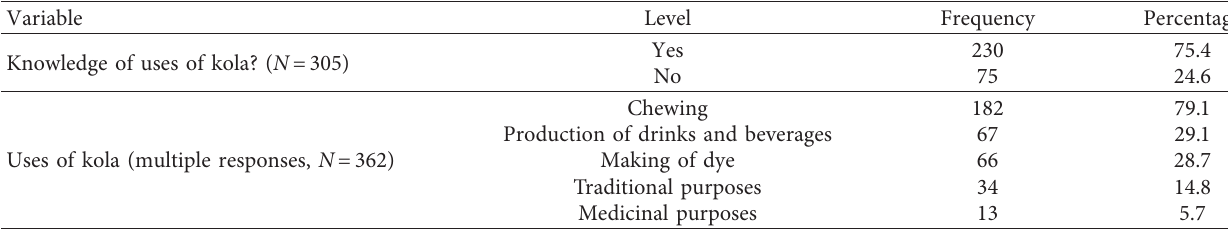
Table 16: Uses of